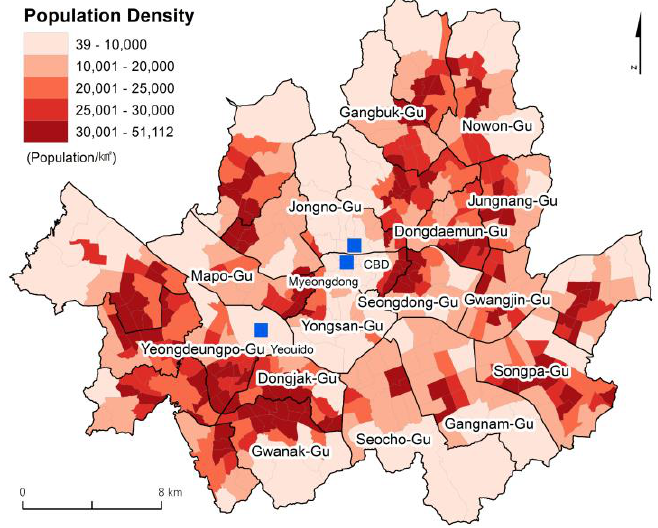
Figure A1. Numbers of alighting population in 2019 for P1 ( A ) and P2 ( B ), and in 2020 for P1 ( C ) and P2 ( D ).